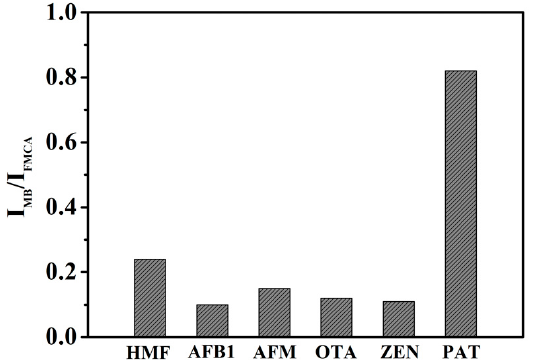
Figure 8. Selectivity of the PAT aptasensor. The concentration of AFB1, AFM, OTA, ZEN and